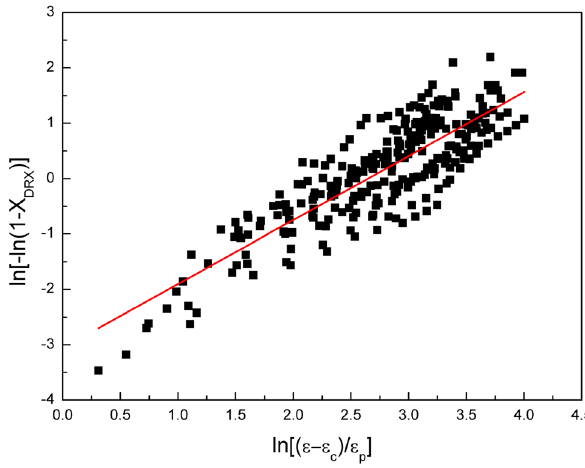
Figure 12: Linear dependence between ln [ − ln ( 1 − X DRX )] and ln [( ε − ε c ) / ε p ] .